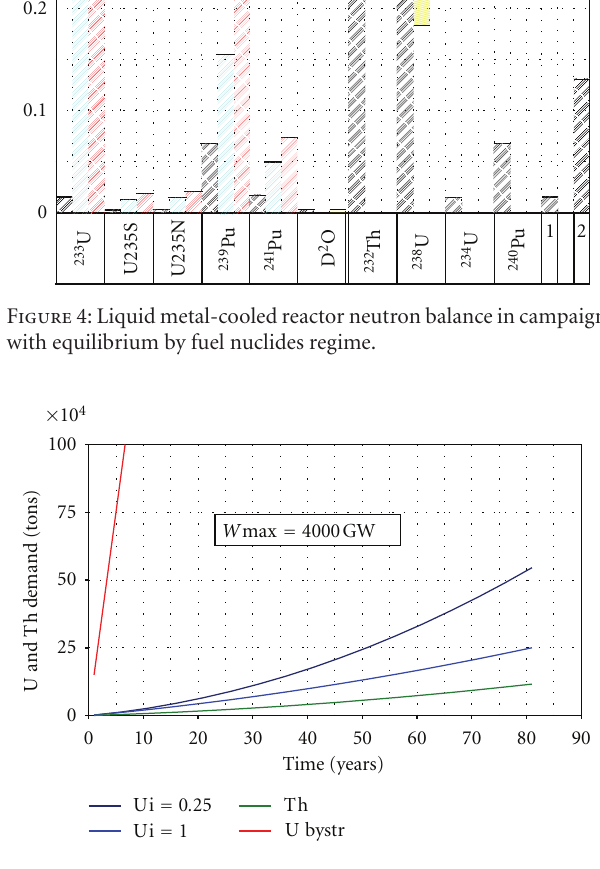
Figure 5: Dependencies of raw uranium and thorium requirement for di ff erent reactor types at the stage of even power growth up to 4000